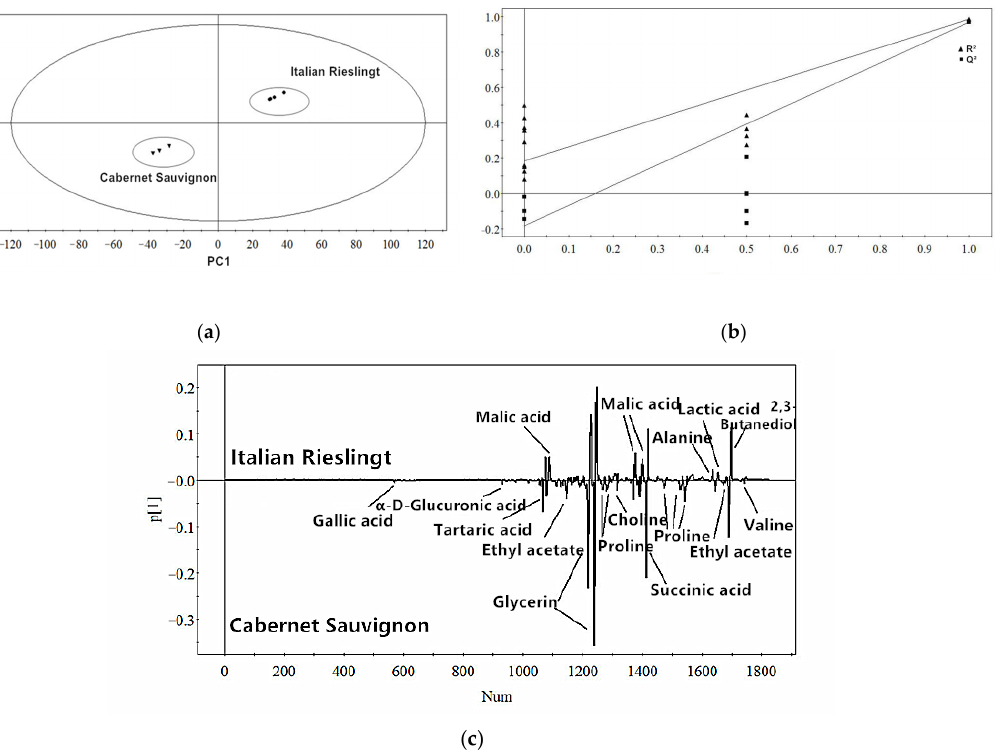
Figure 8. ( a ) PLS-DA model derived from the 1 H-NMR spectra of Cabernet Sauvignon dry red wine and Italian Riesling dry white wine. PLS-DA scores plot; ( b ) PLS-DA cross-validation plot; ( c ) PLS-DA loading plot.